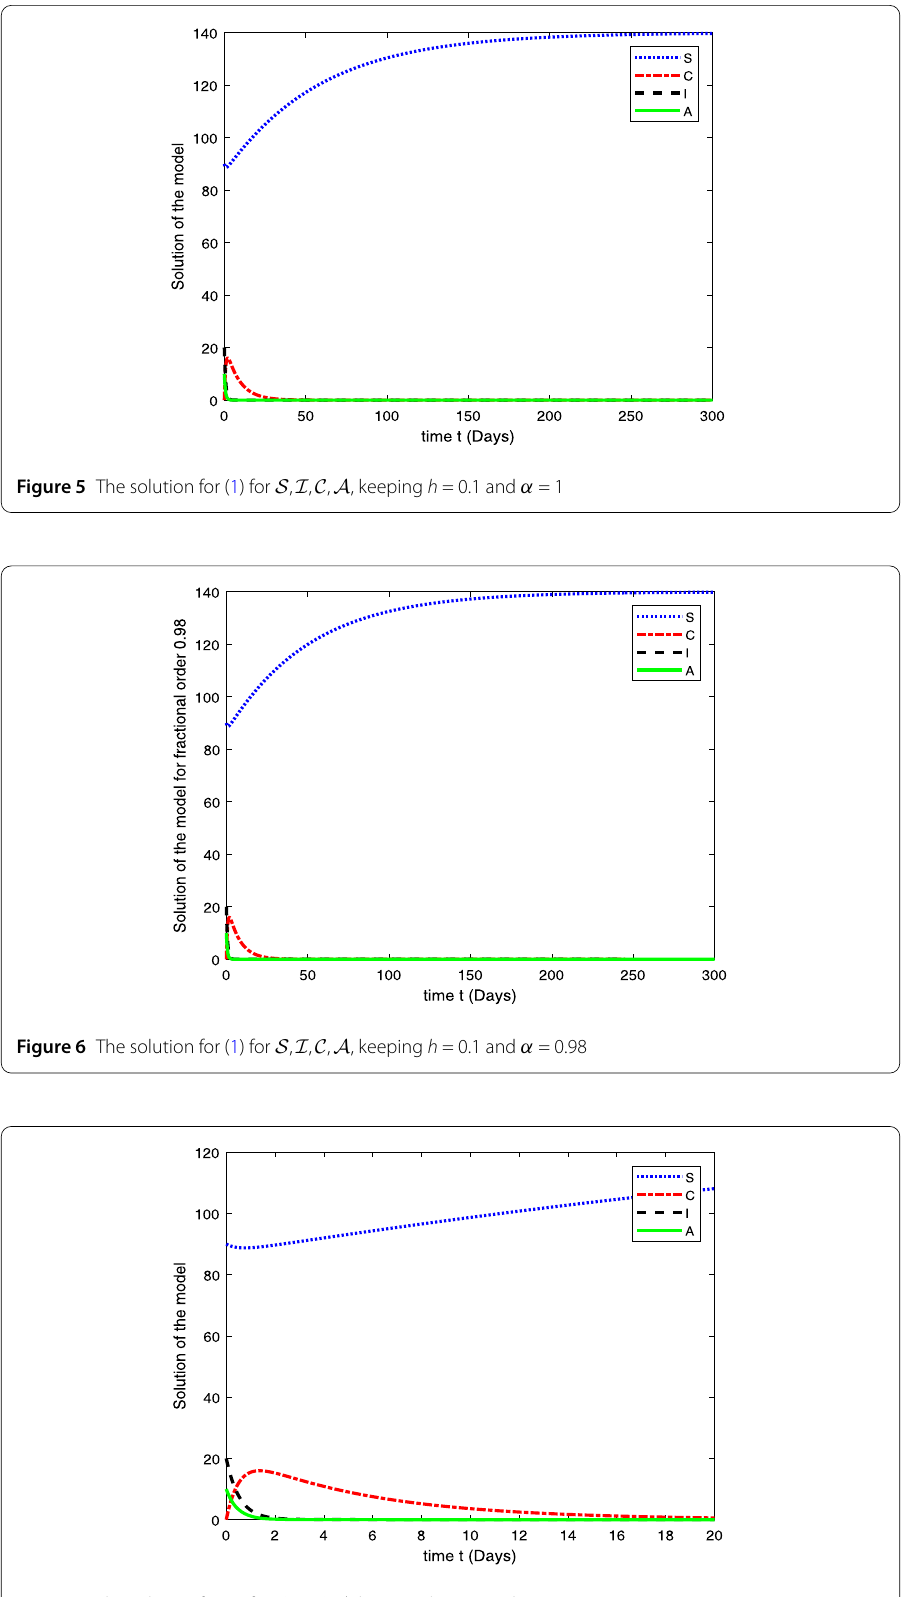
Figure 7 The solution for (1) for S , I , C , A , keeping h = 0.1 and α =